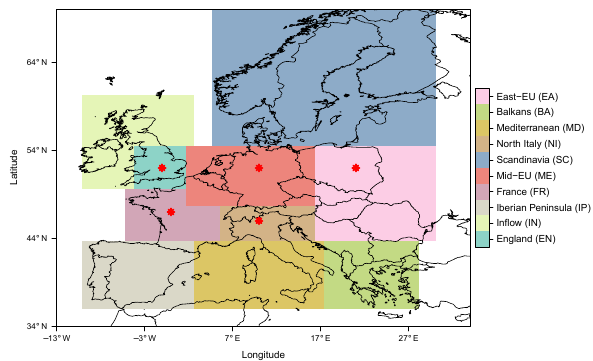
Figure 1. Map of the regions considered in the study. Regions indi- cated with a black star refer to the internal regions in the text. The rest of regions refer to the external regions of the European